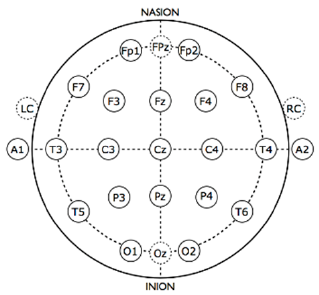
Figure 1. International 10–20 electrode placement.